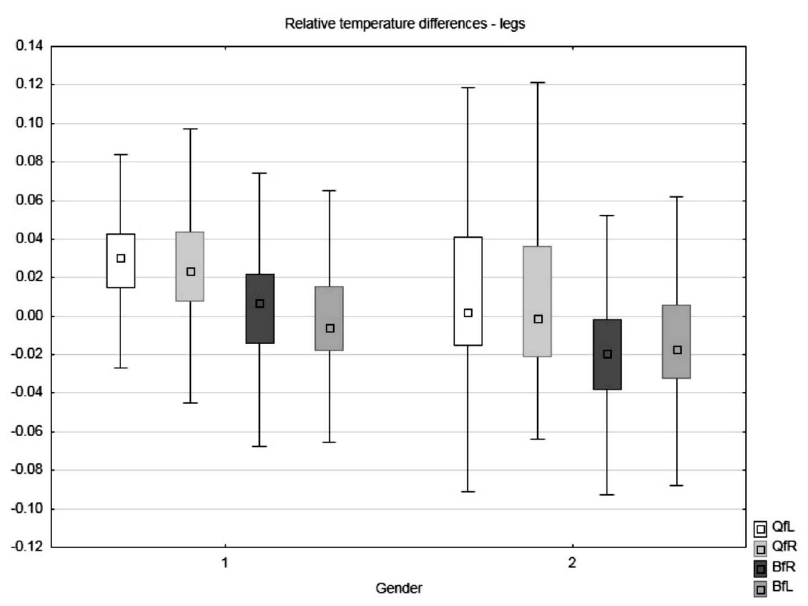
Figure 3. Changes in relative T sk in lower extremities for male (1) and female (2) subjects before and after